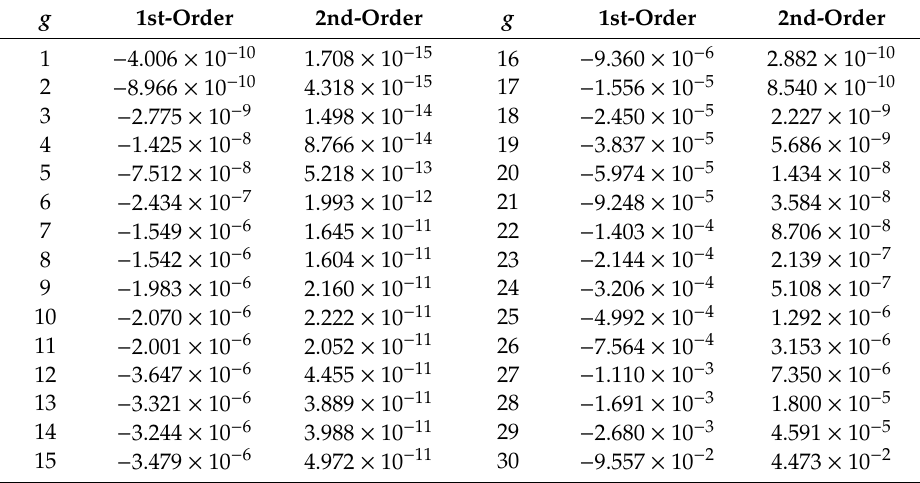
Table 24. Comparison of 1st-order relative sensitivities 2nd-order relative sensitivities sections for isotope 6 ( 1